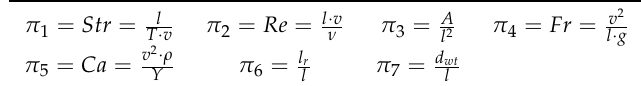
Table 1. Four known and three geometric dimensionless quantities. Str denotes the Strouhal number, Re the Reynolds number, Fr the Froude number, and Ca is the Cauchy